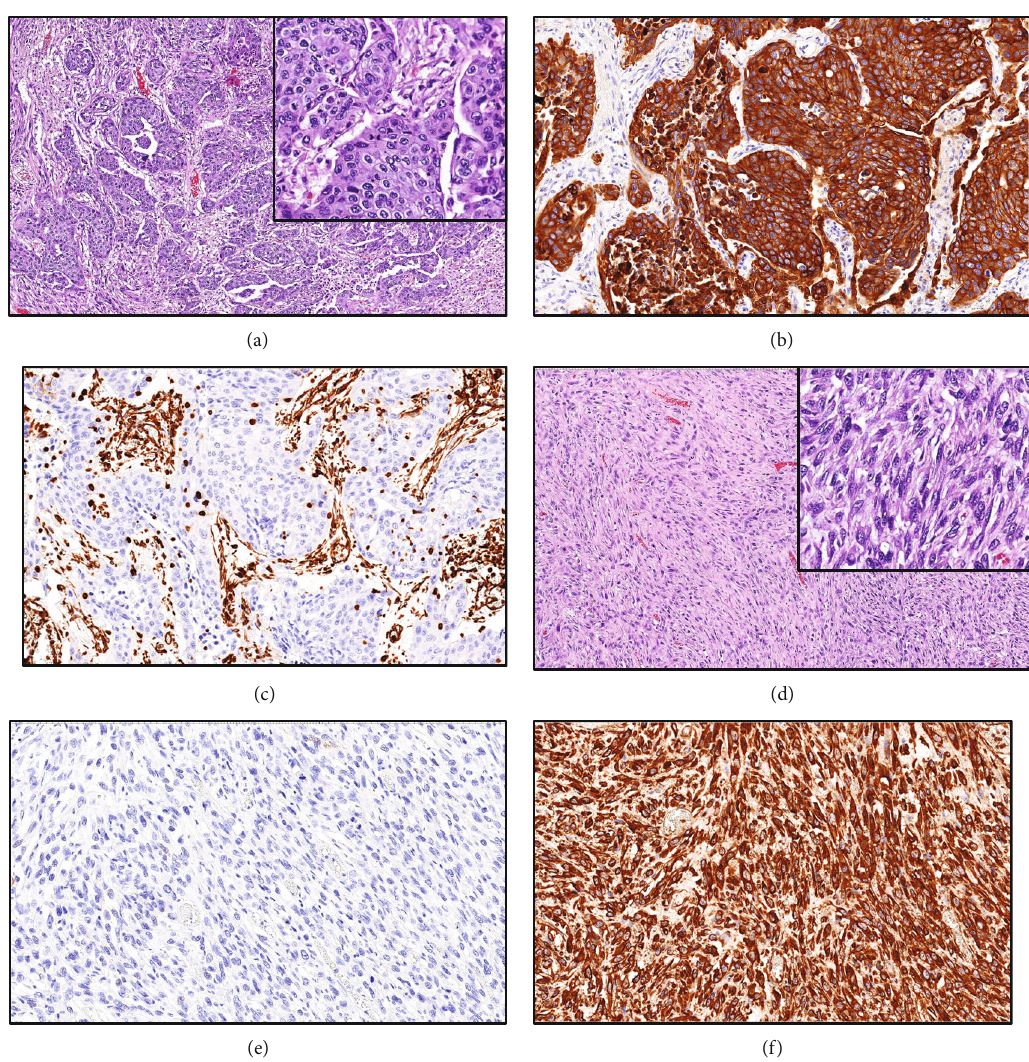
Figure 4: Histopathology. The polygonal cell population is represented in panels (a – c). Hematoxylin and eosin section with high magni fi cation insert (a). Note the trabeculae and nests of polygonal cells and intervening stroma with a high number of mitotic fi gures (see inset). A1/A3 cytokeratin IHC stain (b). Note the strong staining of the polygonal cells consistent with epithelial cells and lack of stromal staining. Vimentin IHC stain (c). Note the lack of staining of the polygonal cells and sparse stromal staining. The spindle cell population is represented in panels (d – f). Hematoxylin and eosin section with high magni fi cation insert (d). Note streams and bundles of spindled cells. A1/A3 cytokeratin IHC stain (e). Note the lack of staining of the spindle cells. Vimentin IHC stain (f). Note the strong staining of the spindle cells consistent with mesenchymal cells such as a fi broblast. IHC: